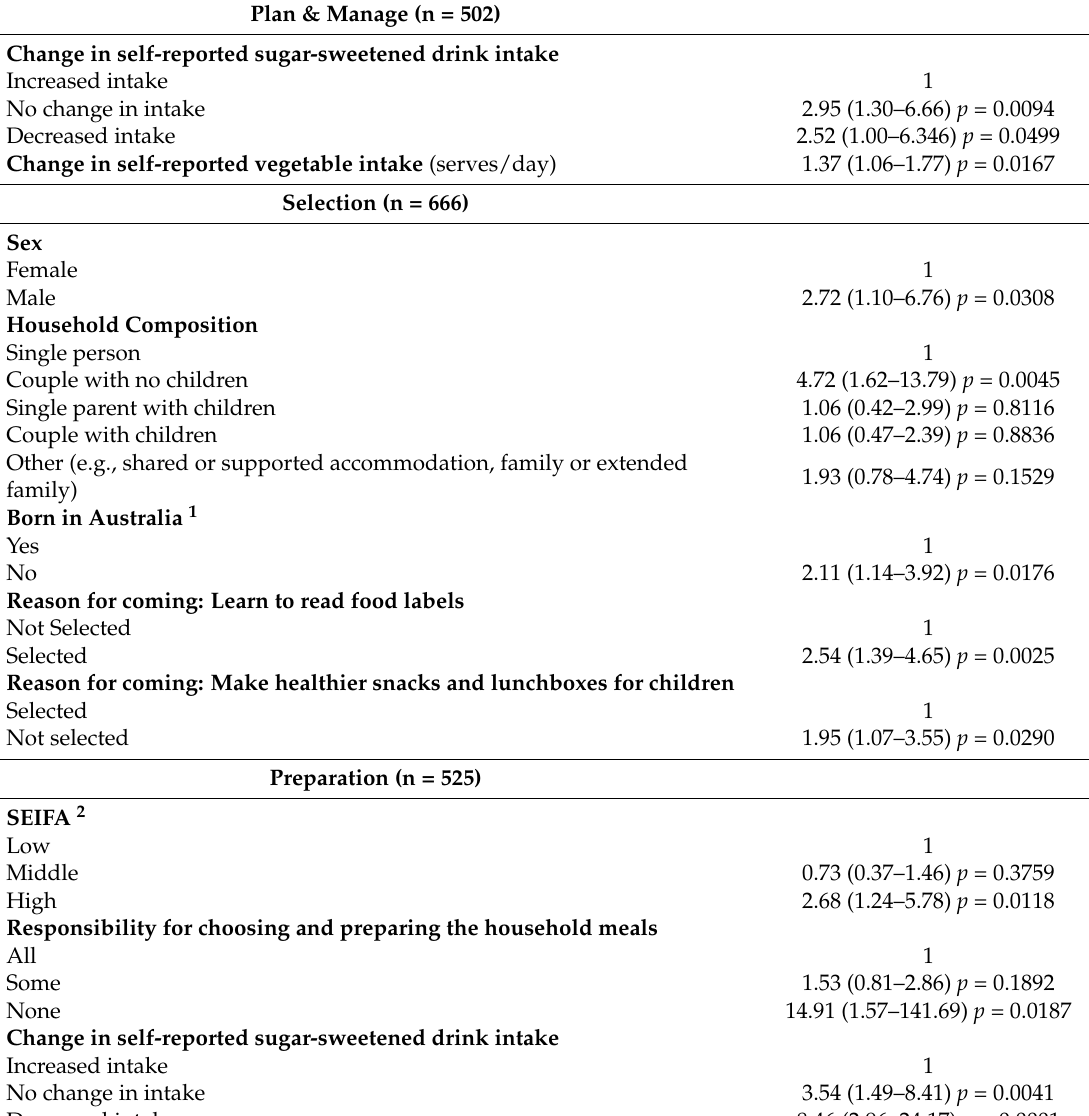
Table 6. Demographic and dietary behaviours associated with food literacy behaviour